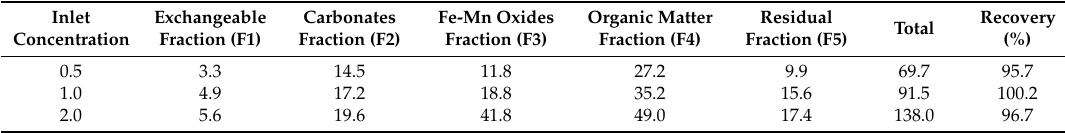
Table 10. The total concentration and speciation of copper